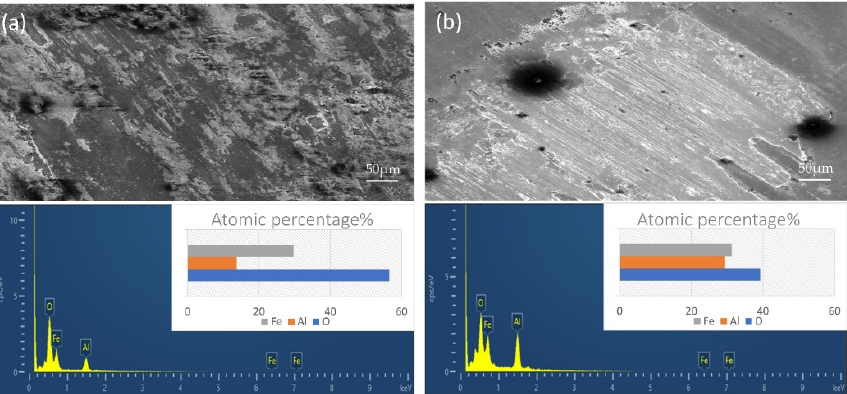
Figure 13. Microscopic morphology and elemental analysis of coated abrasion marks: ( a ) 12 N; ( b ) 20 N.